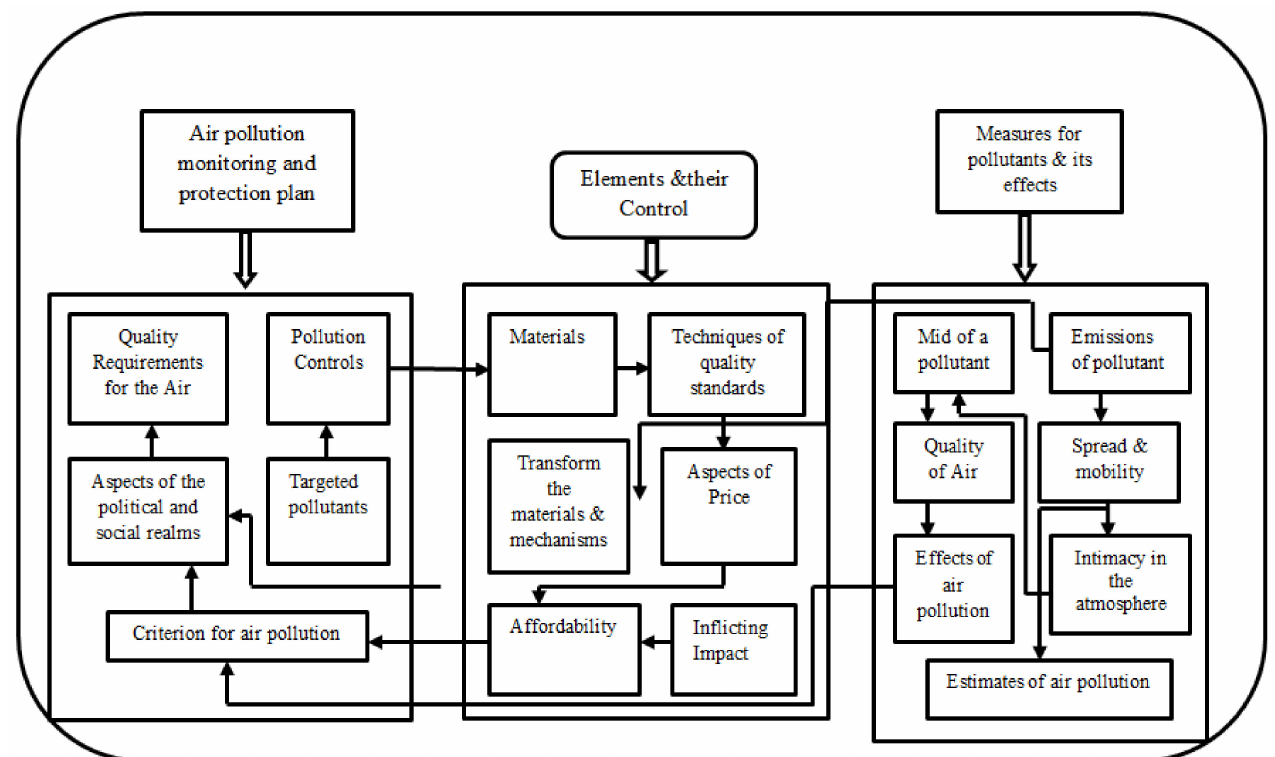
Figure 1. Model of the air pollution management system. Temperature, velocity vector, high humidity, air velocity, and other such influential pa- rameters were indeed gleaned from the aforementioned sources [12]. Dependent variables were removed from the research design before they could be used for analysis. Options, such as pollutants, are approximated by utilizing an imputer program to estimate the null values; the normal distribution estimate is applied in this case. All characteristics are converted for ease of calculation just before the input is homogenized [13]. As a result, the degree-based performance parameters for wind conditions have been transformed into a wind speed index. To ensure that all qualities have greater validity, it is easy to boost the input’s properties to a certain